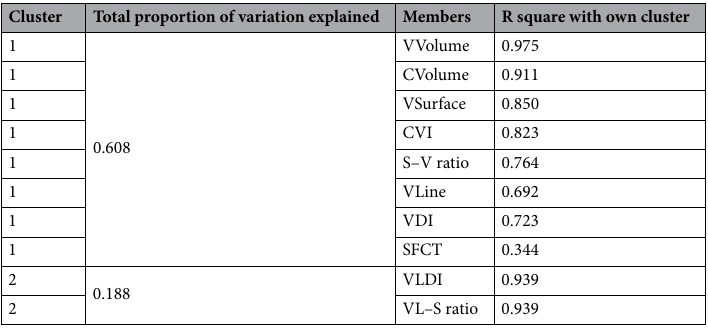
Table 4. Cluster analysis of the